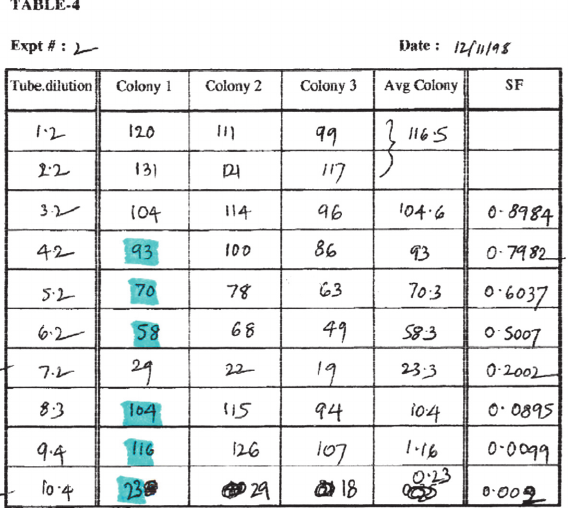
Figure 2. PDF image of colony counts from an experiment performed by RTS . The rounded average (highlighted in blue) appears as one of the triplicate counts in six of the 10 samples (ppoibin Prob = 0.00152). For rounding, means with ≥ 5 after the decimal are rounded up and means with < 5 after the decimal are rounded